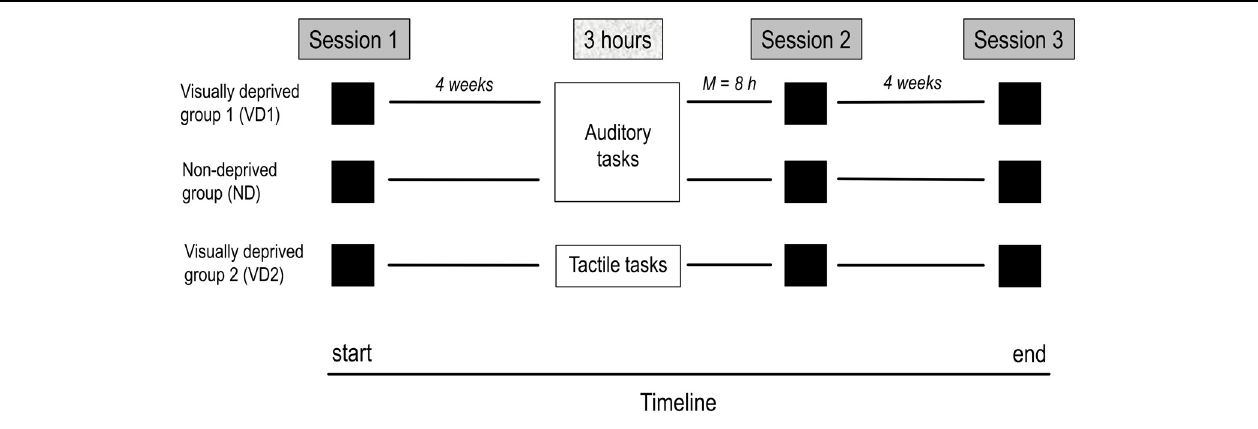
FIGURE 1 | Timeline of the study. The study comprised three testing sessions, separated by 4 weeks on average, and a 3 h period of visual deprivation and/or administration of a task battery (VD1: visual deprivation and auditory tasks, ND: auditory tasks, VD2: visual deprivation and tactile tasks)